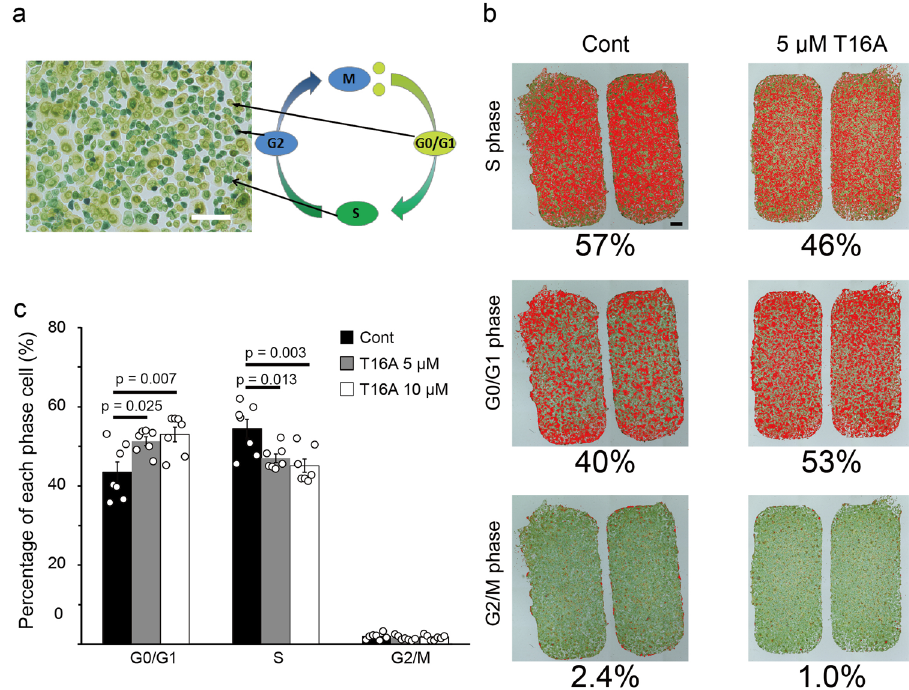
Fig. 9 Effects of an ANO1 inhibitor on the cell cycle of NHEKs. a A representative image of redox dye staining for cell cycle analysis. The scale bar indicates 100 μ m. b Representative images of cells in the presence or absence of 5 μ M T16A in the cell culture insert. Cells marked in red are in the indicated phase. The scale bar indicates 500 μ m. c Comparison of the percentages of each phase. Data represent means ± SEM ( N = 7). Statistical signi fi cance was determined with one-way ANOVA followed by Dunnett